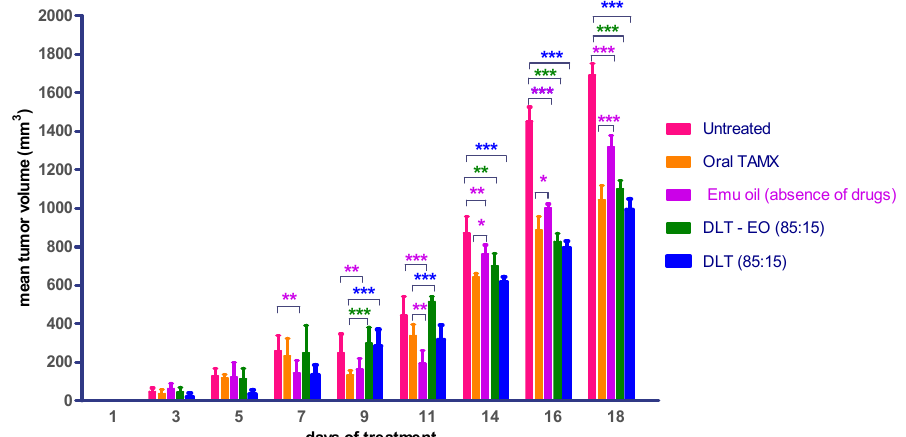
Figure 3. Mean tumor volume of BALB / c mice treated with oral TAMX, emu oil, and transfersomal formulations with / without emu oil. DLT—deformable liposomes, DLT–EO—deformable liposomes with emu oil. Each value is the mean ± SD ( n = 3). (* p < 0.05; ** p < 0.01; *** p < 0.001).